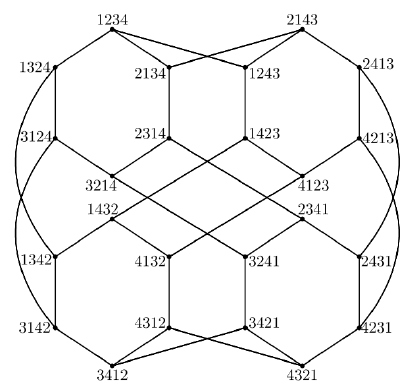
Figure 2. The Bubble-sort graph BS 4 = Cay ( S 4 , { ( 12 ) , ( 23 ) , ( 34 ) } )